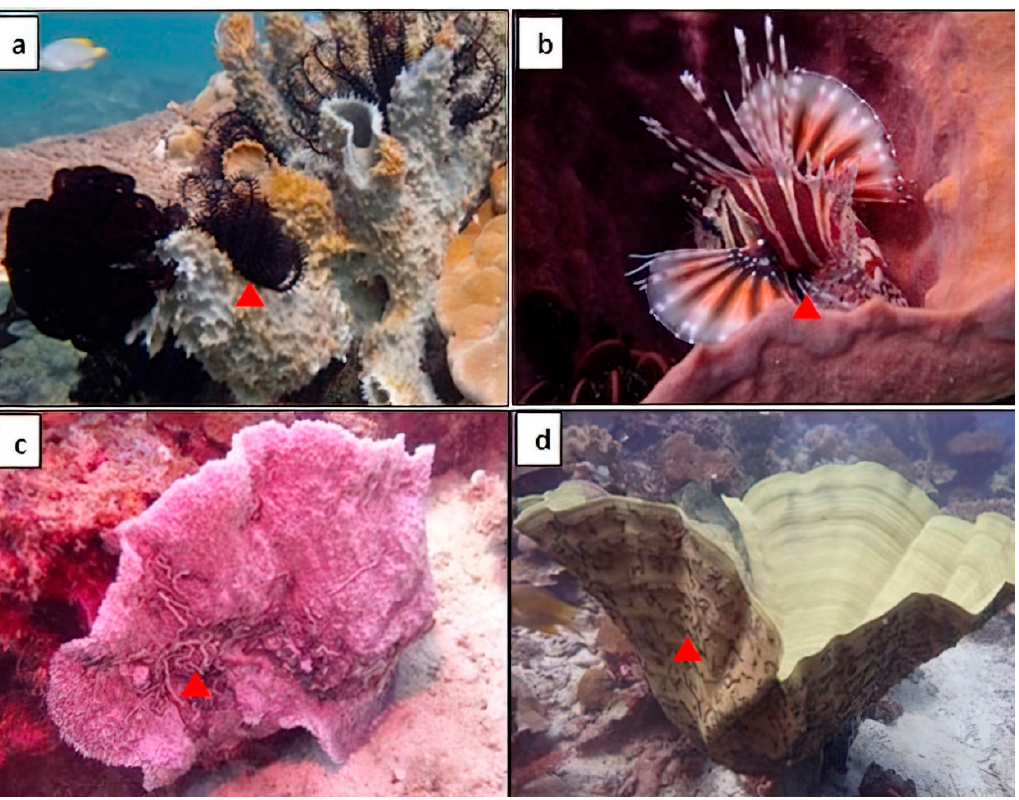
Figure 2. Numerous symbiotic macroscopic creatures reside inside or on the surface of a sponge. ( a ) Crinoid feather star, ( b ) Red lionfish, and ( c , d ) Synaptid sea cucumber.